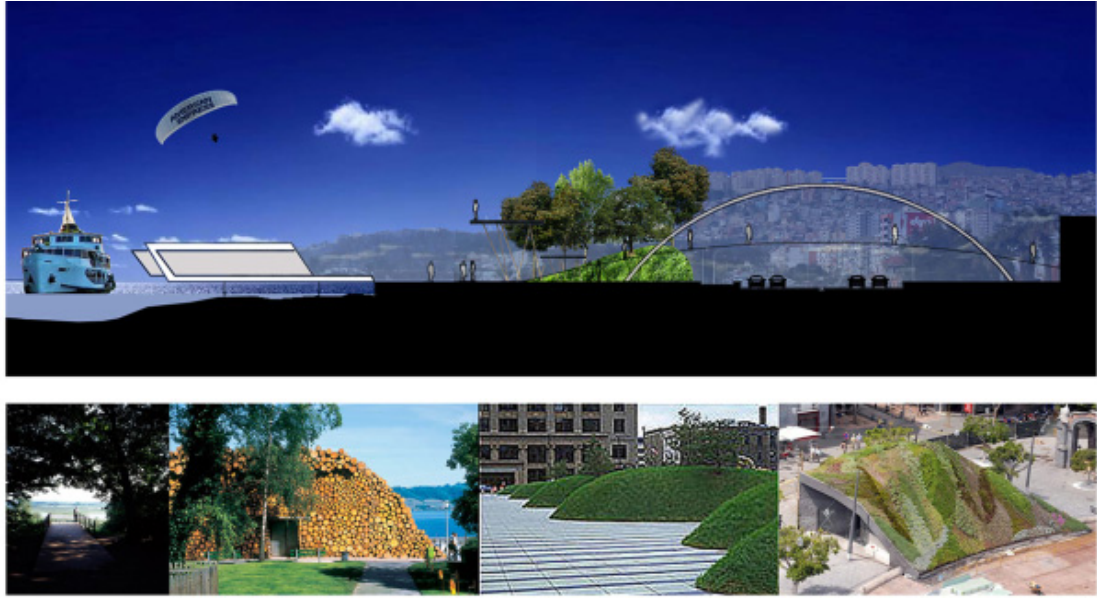
Figure 5. The design proposal for Bayrakl ı District, by the design team of the second sub-region, İ zmirdeniz Project, 2012. Reproduced with permission from Metin K ı l ı ç, published by M+D Mimarl ı